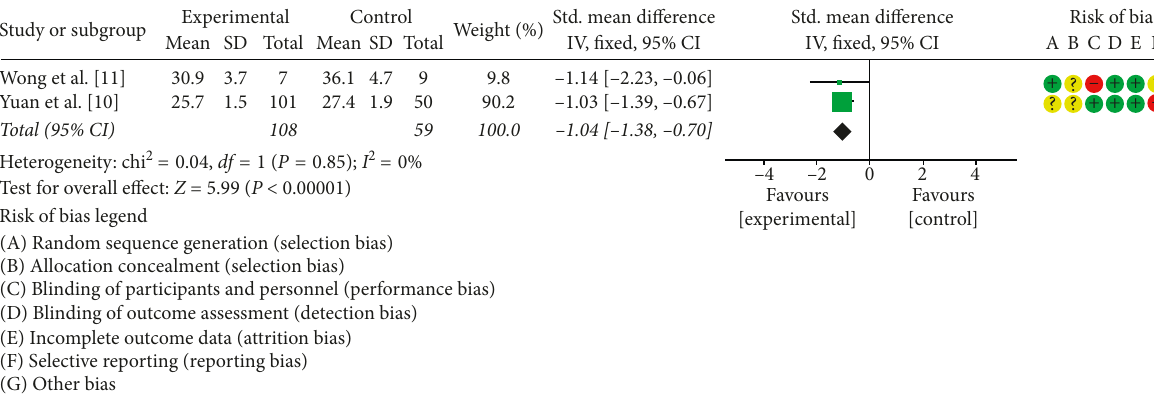
Figure 3: Meta-analysis of the effect of LCD on BMI in PCOS patients.